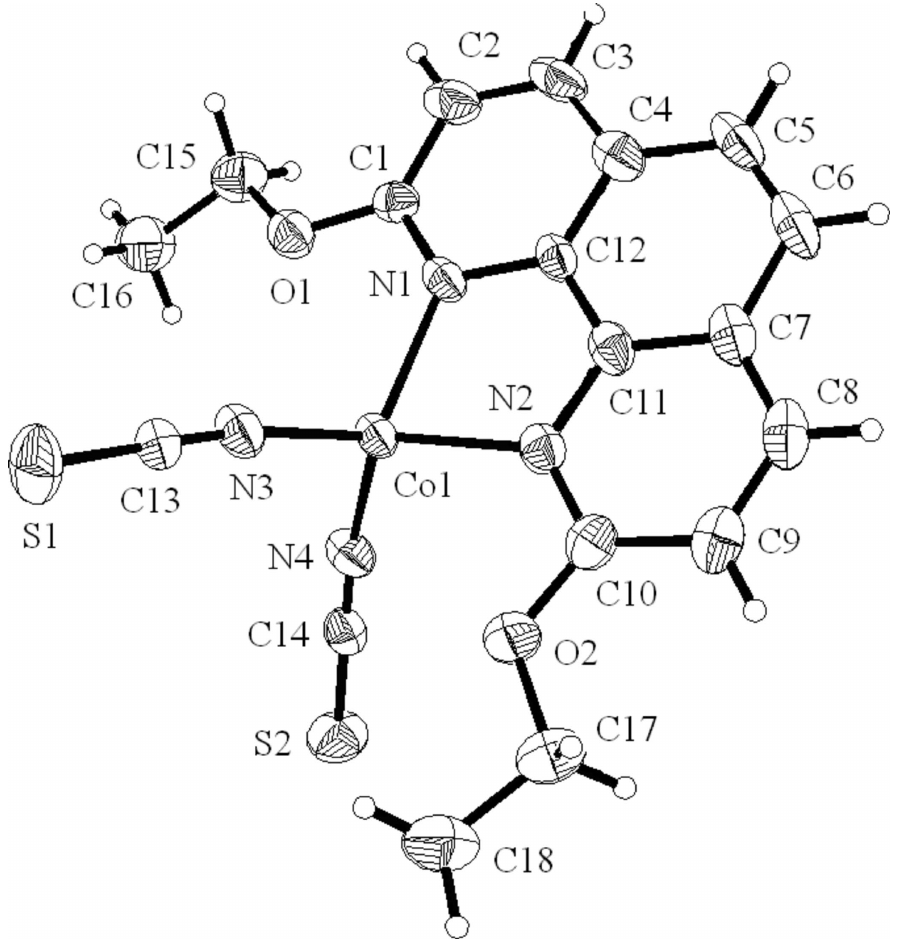
Figure 1 A view of the title complex, showing the atom-labelling scheme. Displacement ellipsoids are drawn at the 30% probability level and H atoms are shown as small spheres of arbitrary